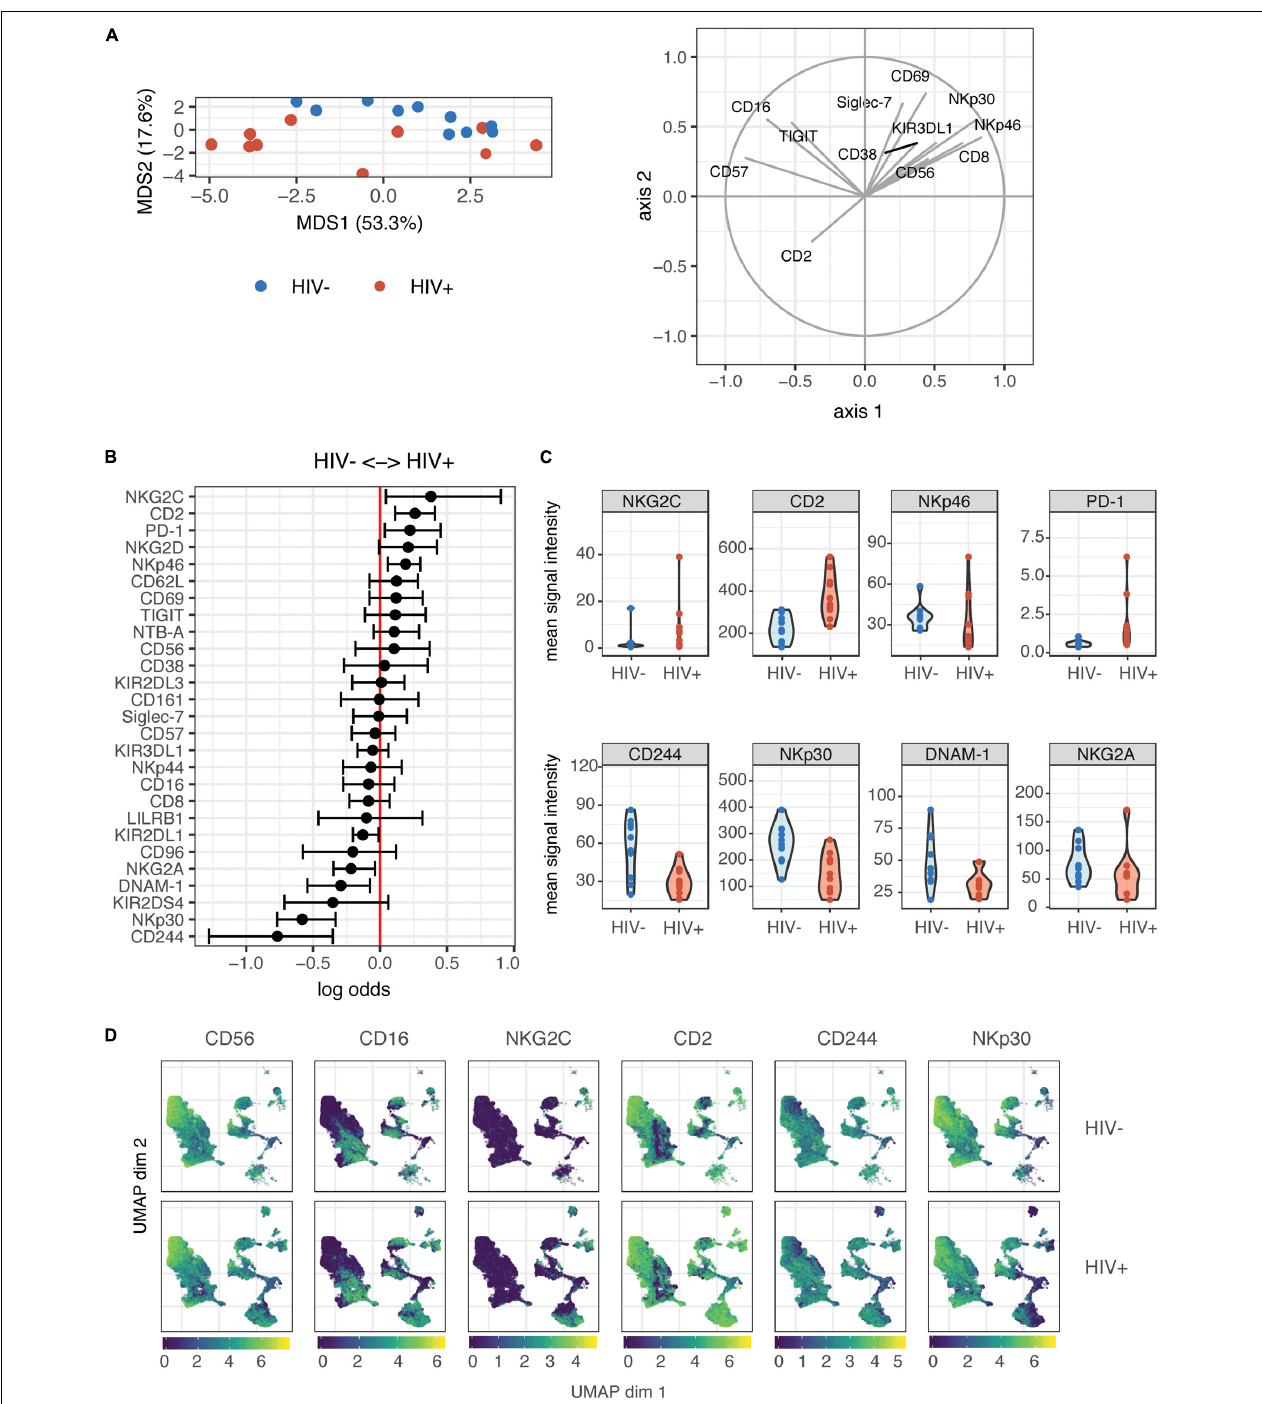
FIGURE 1 | Profiling of NK cell repertoire using CyTOF in both healthy, HIV– and ART-suppressed, HIV+ donors demonstrates alterations in NK cell surface receptor expression. (A) Multidimensional scaling (MDS) plot showing separation of NK cells from HIV+ ( n = 10) and HIV– donors ( n = 10). Only markers whose contributions are greater than 0.25 in both MDS1 and MDS2 are displayed in the marker loadings. (B) A generalized linear model with bootstrap resampling was used to find receptors predictive of either HIV+ (right), or HIV– (left) donor NK cells. Log-odds are logarithm of ratios of the probability that a cell belongs to either group. For each marker, the 95% confidence interval is represented by the line surrounding the point estimate; a larger absolute log-odds value of the parameter indicates that the marker is a stronger predictor. (C) Mean signal intensity (MSI) of NKG2C, CD2, NKp46, and PD-1 (top 4 predictors of the HIV+ group; top), and CD244, NKp30, DNAM-1, and NKG2A (top 4 predictors of the HIV– group; bottom). (D) UMAP visualization of all NK cells from the HIV+ and HIV– groups, colored by expression of CD56, CD16, NKG2C, and CD2 (top 2 predictors of the HIV+ group), and CD244 and NKp30 (top 2 predictors of the HIV– group). Scales show asinh-transformed channel